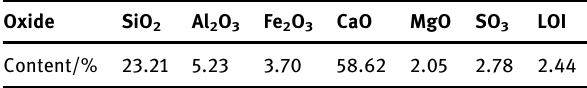
Table 1: The chemical compositions of